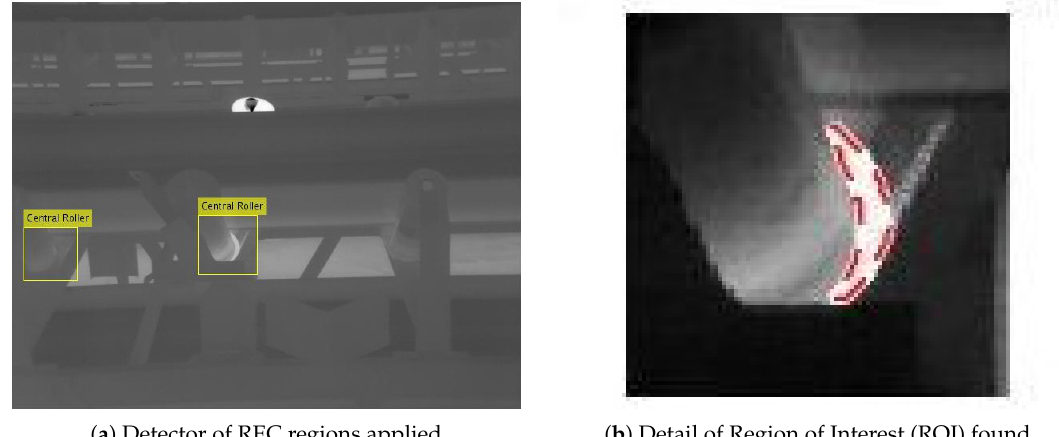
Figure 11. Defective roller found through the hybrid method: ( a ) ROIs selected. ( b ) Detail of the defective roller inside the selected